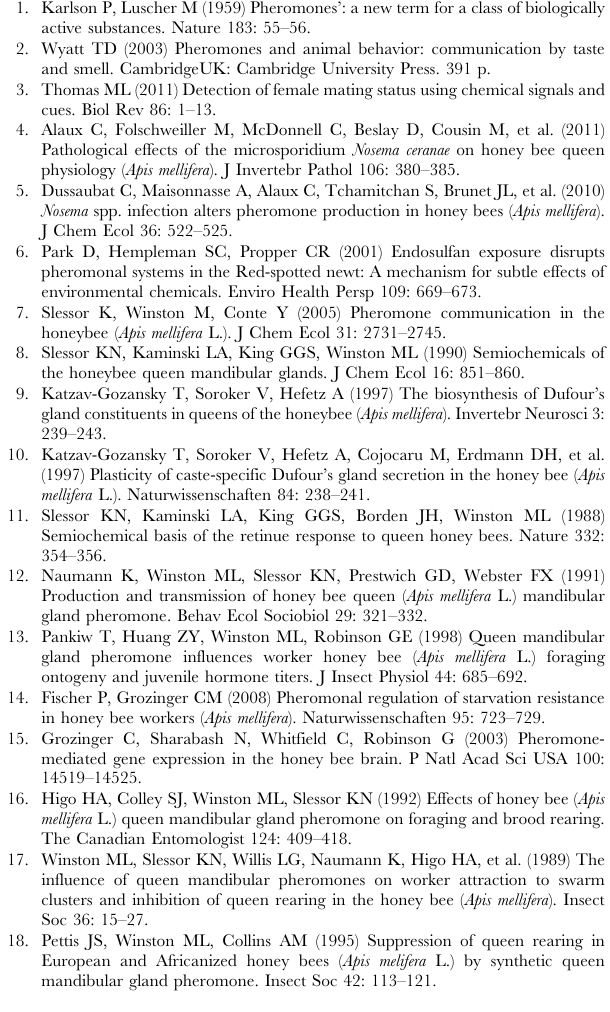
queens exposed to CO 2 and CO 2 + physical manipula- tion. (XLSX) Table S4 Information for the ten most abundant ions (m/z and intensities) for each of the unknown com- pounds found in the mandibular gland extracts of the queens instrumentally inseminated with low or high volume of either saline or semen.